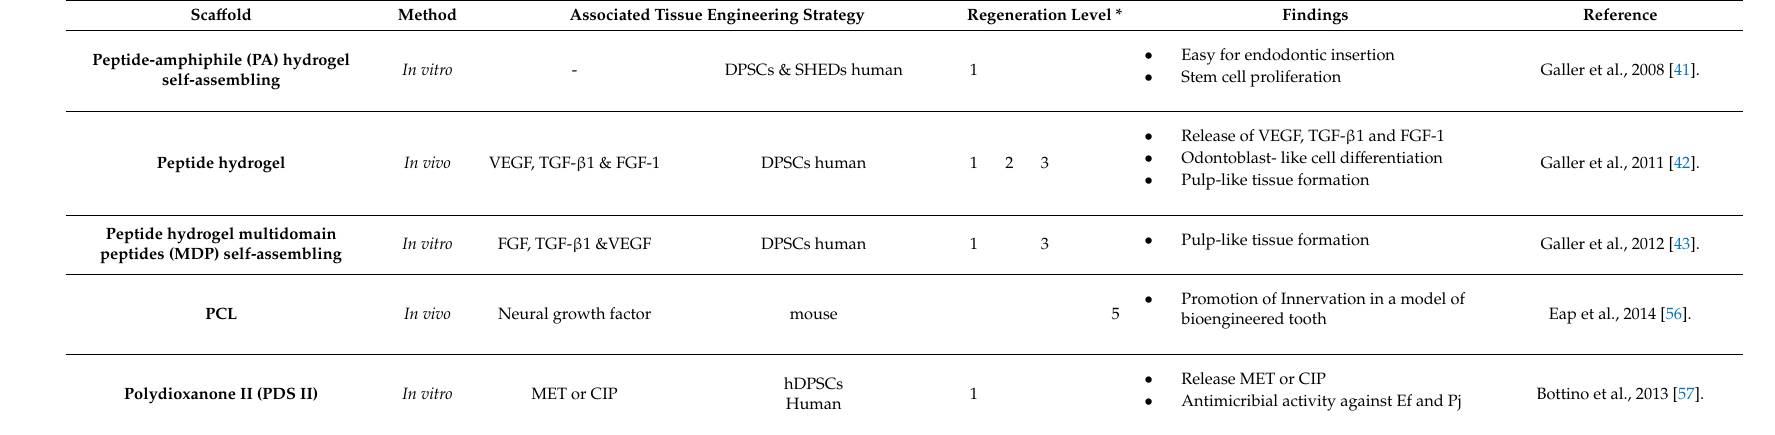
Table 1. Main instructive polymer sca ff olds for di ff erent levels of endodontic